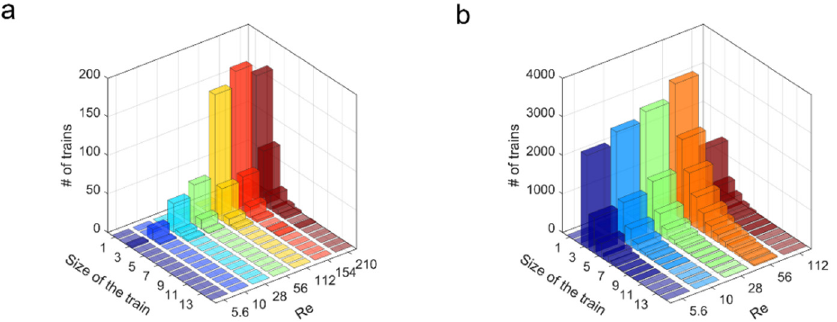
Figure 8 . Composition of the trains with respect to Re observed at z/H = 1000 for d p /H = 0.11 with ( a ) Φ = 0.05% and ( b ) Φ = 1%, ( a ) Φ = 0.05% and ( b ) Φ = 1%, respectively.